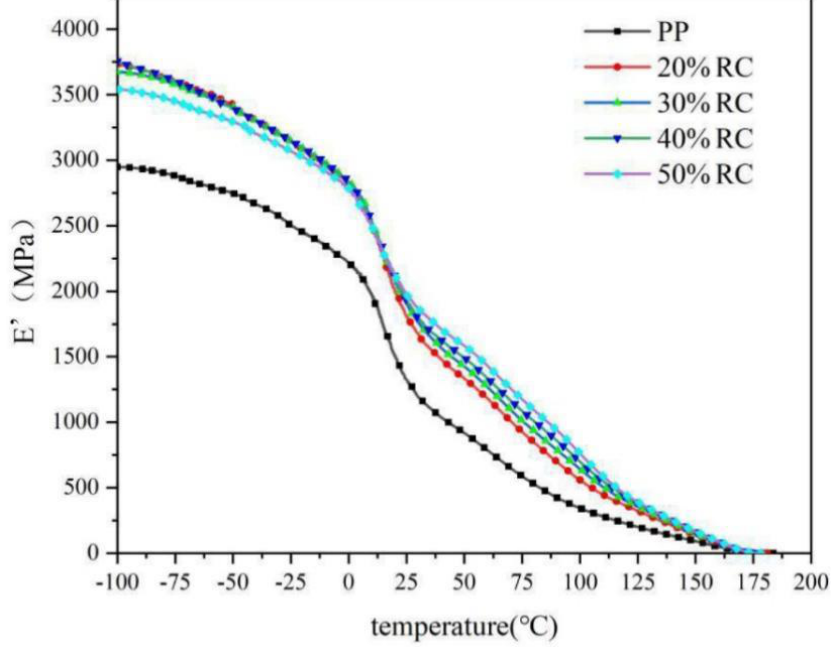
Figure 7. Storage modulus curve of RC/PP Composites.